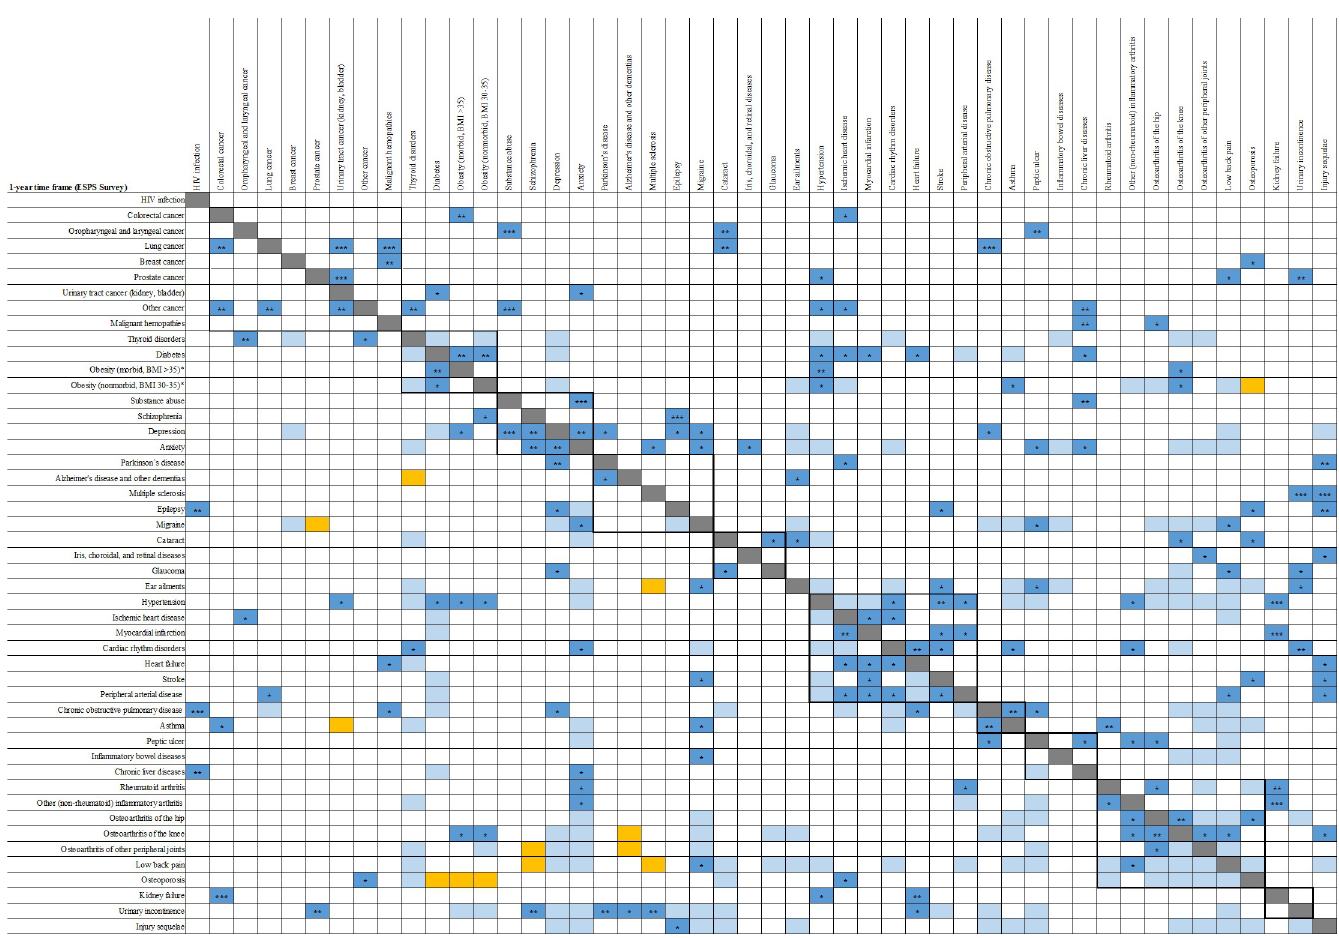
Fig 4. Independent associations between the 48 selected chronic conditions. Associations were identified in logistic models built with forward and backward stepwise procedures to identify the conditions independently associated with each condition while adjusting for age and sex. Upper right panel, above the diagonal: ESPS survey and 1-year time frame; lower left panel, below the diagonal: HSM survey and lifetime frame. Obesity is categorized according to the standard BMI criteria (obese: BMI 30–35; morbidly obese: BMI > 35) and analyzed as a 3-category variable. A light blue box indicates an OR � 2. A star sign ( � ) indicates an OR between 2 and 4; 2 stars ( �� ) indicate an OR between 4 and 10; 3 stars ( ��� ) indicate an OR � 10. An orange box indicates a negative association (OR < 1). Frames indicate conditions within the same ICD-10 chapter. BMI, body mass index; ESPS, Enqu ê te Sante´ et Protection Sociale; HIV, human immunodeficiency virus; HSM, Enqu ê te